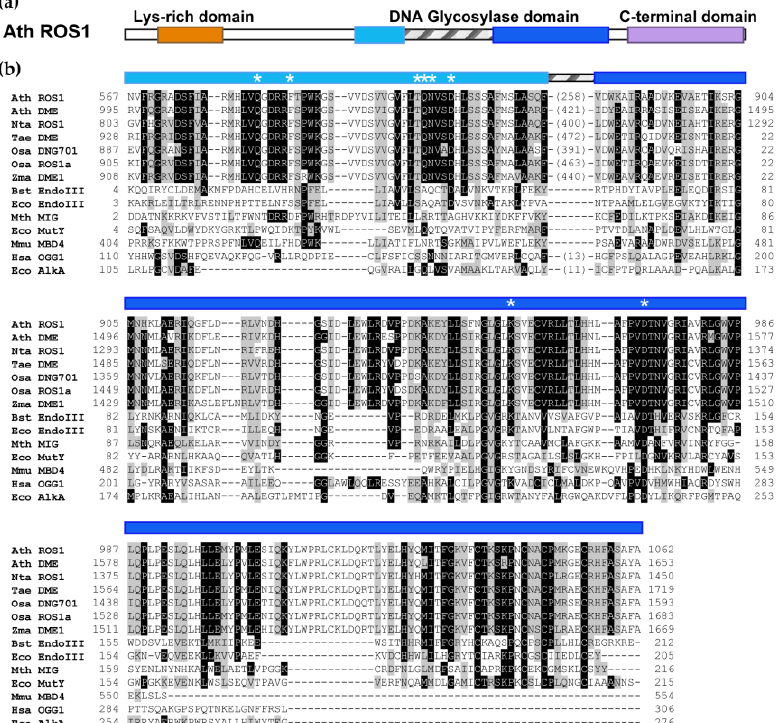
Figure 1. Bipartite DNA glycosylase domain in members of the DEMETER-LIKE (DML) family. ( a ) Schematic representation of ROS1 domains conserved among DML proteins. ( b ) Multiple sequence alignment of DML and HhH-GPD representative proteins. Critical residues for catalysis or DNA binding in ROS1 (REPRESSOR OF SILENCING 1) are indicated by asterisks (see text for more details). Names of organisms are abbreviated as follows: Ath, Arabidopsis thaliana; Nta, Nicotiana tabacum; Ta, Triticum aestivum; Osa, Oryza sativa; Zma, Zea mays; Bst, Bacillus stearothermophilus; Eco,